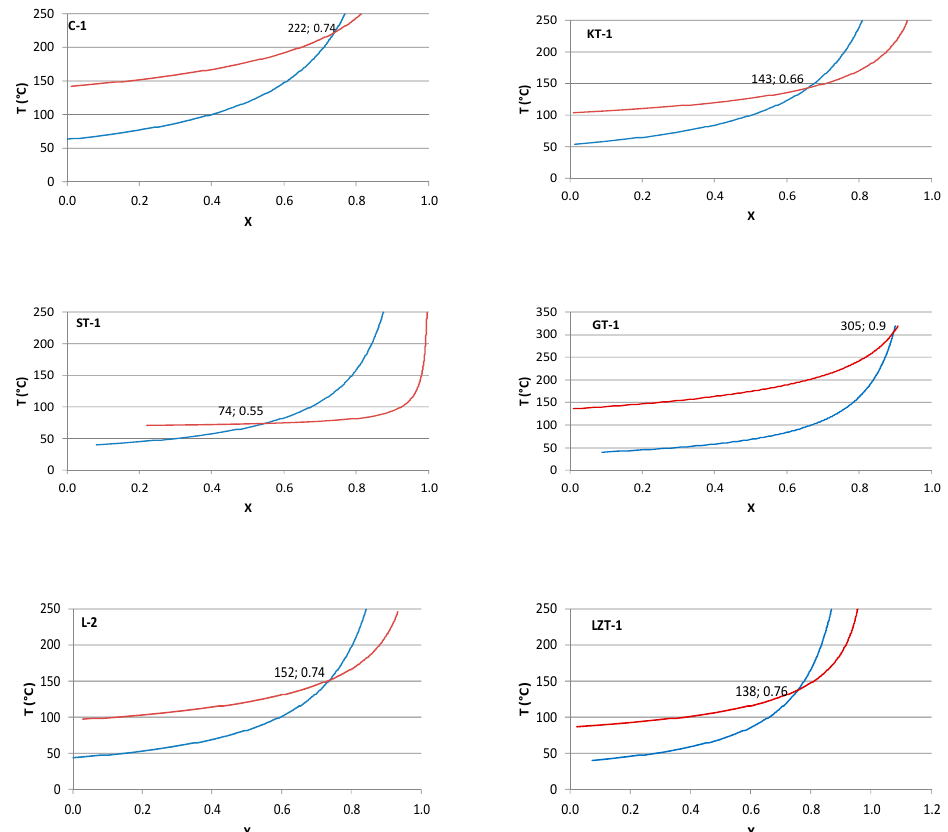
Figure 7. The proportion of cold waters (X) in thermal water mixtures in particular locations, and the temperatures (T) of hot deep components; the blue line—the proportion of cold waters based on enthalpy/temperature changes, the red line—the proportion of cold waters based on variation in silica concentrations (T-X graph). Table 4. Reservoir temperatures determined on the basis of the dependence of silica dissolution on the enthalpy of thermal waters (based on the determined enthalpy [72] and Figures 7 and 8); temperature in ◦